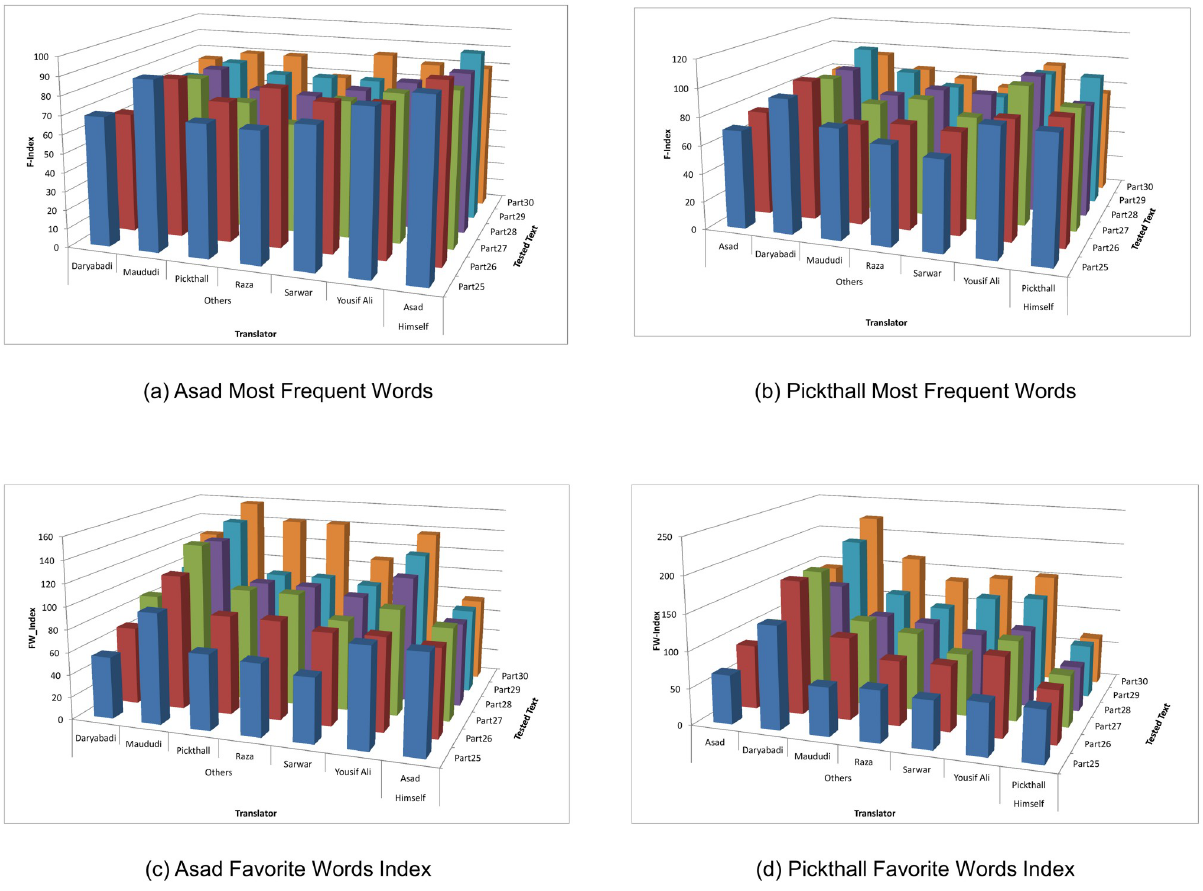
Fig 3. Comparison between most frequent words index and favorite words index for translators Asad and